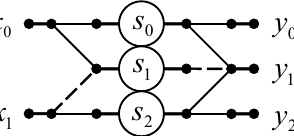
Figure 1. The signal flow graph of the proposed algorithm for computation of 2-point linear